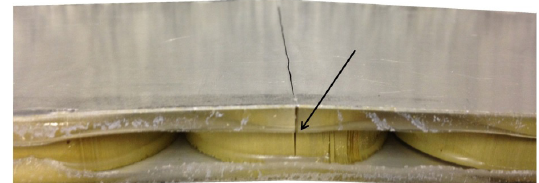
Figure 8. Bamboo fracture achieved for Ø45 mm panels.